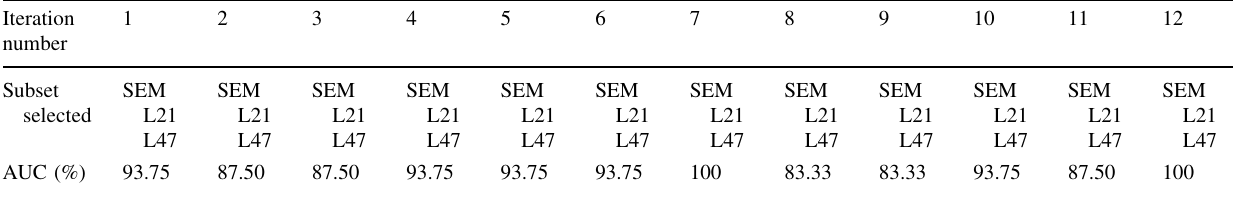
Table 3 Results obtained for the selected subset SEM (semantic) LH (left hemisphere) BA 21 and BA47 in terms of AUC as the performance metric for each iteration of the outer MCCV, using